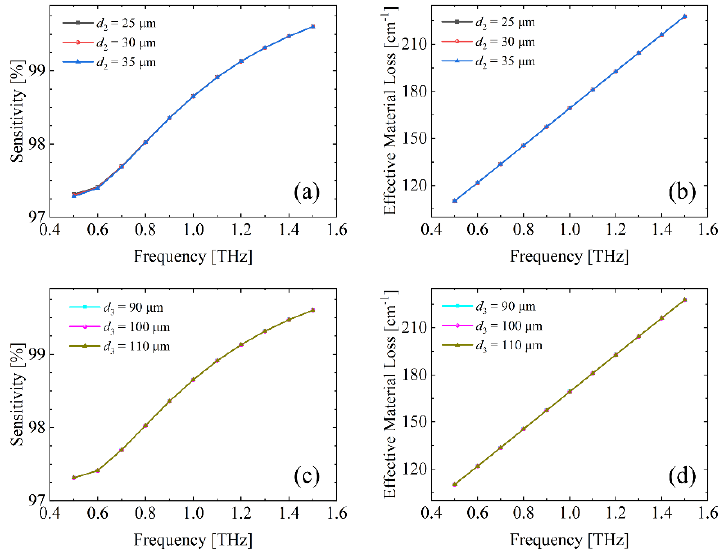
Figure 5. Behavior of ( a , c ) relative sensitivity and ( b , d ) EML core power fraction relative to frequency for different values of d 2 and d 3 .